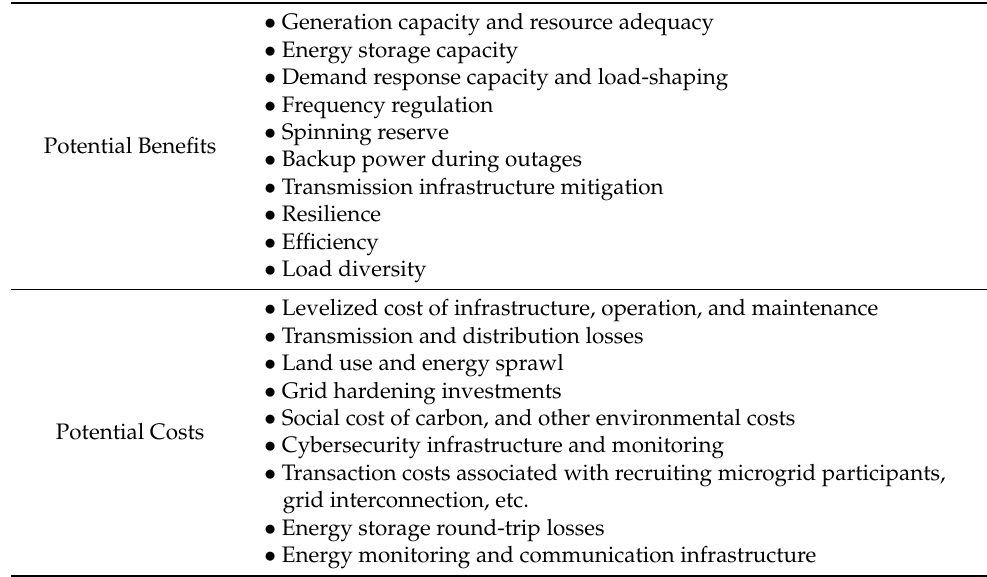
Table 1. Some cost-effectiveness considerations relevant to microgrid